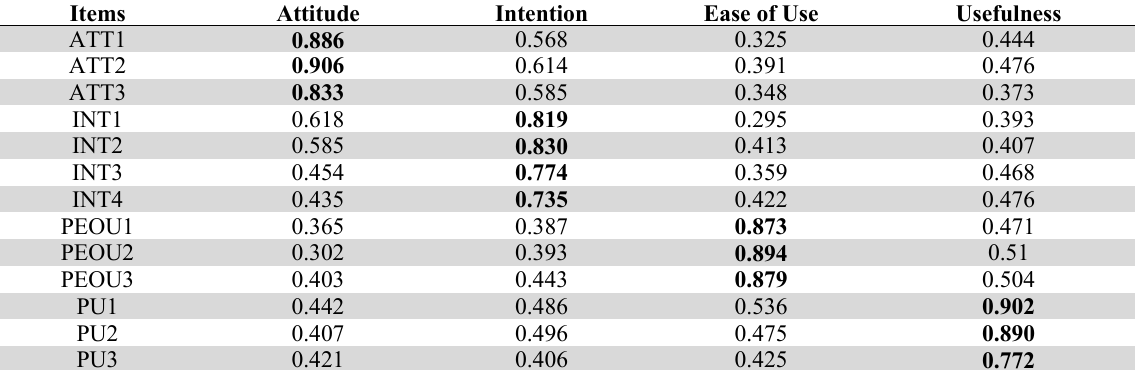
Loading and Cross